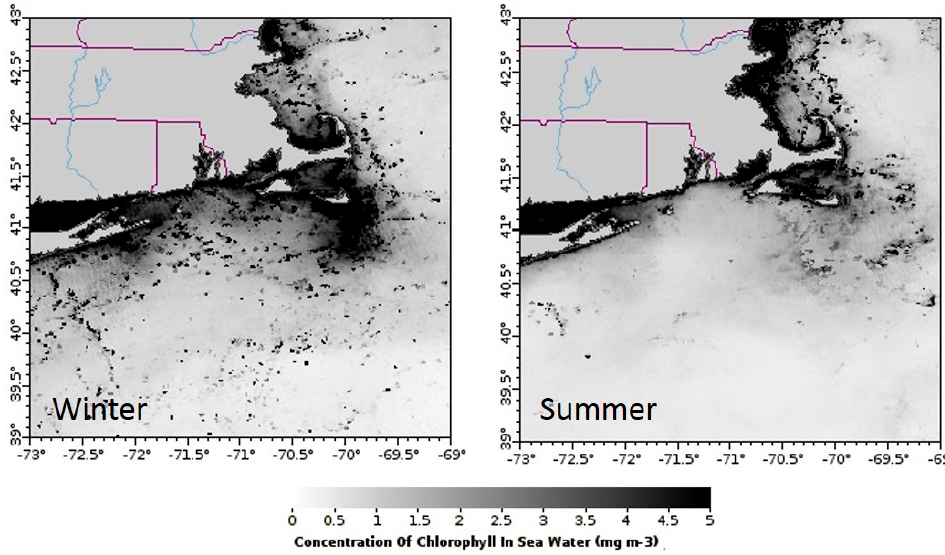
Figure 3. MODIS satellite mean winter (February 2012) and summer (June 2012) surface chlorophyll concentration image of the American Atlantic NE Shelf (Source: NOAA NFMS SWFSC ERD).